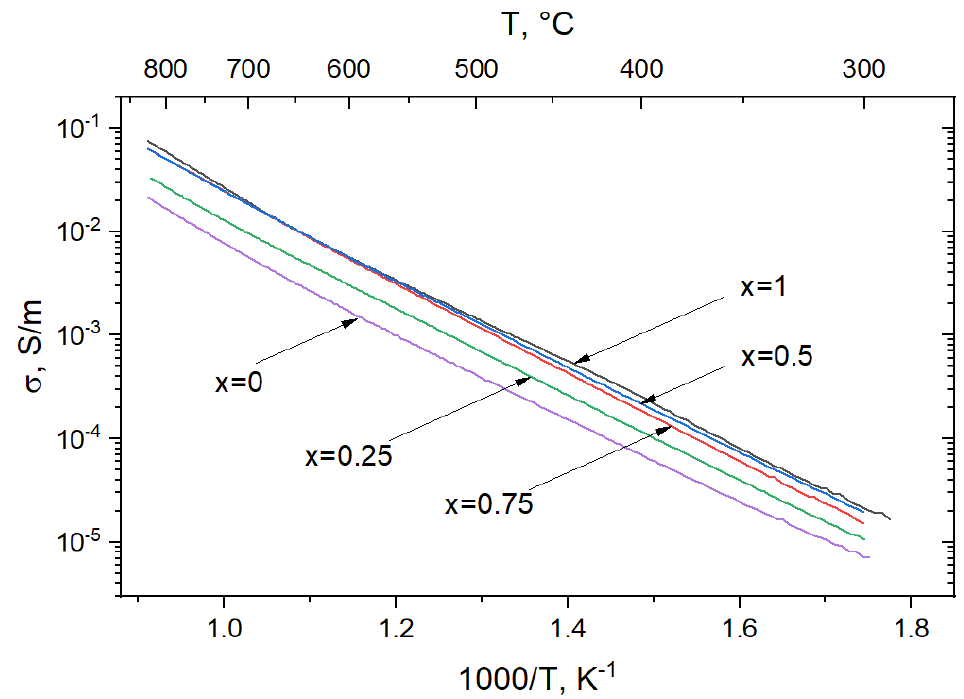
Figure 14. Temperature dependence of conductivity of LiNb 1 − x Ta x O 3 pressed pellets.